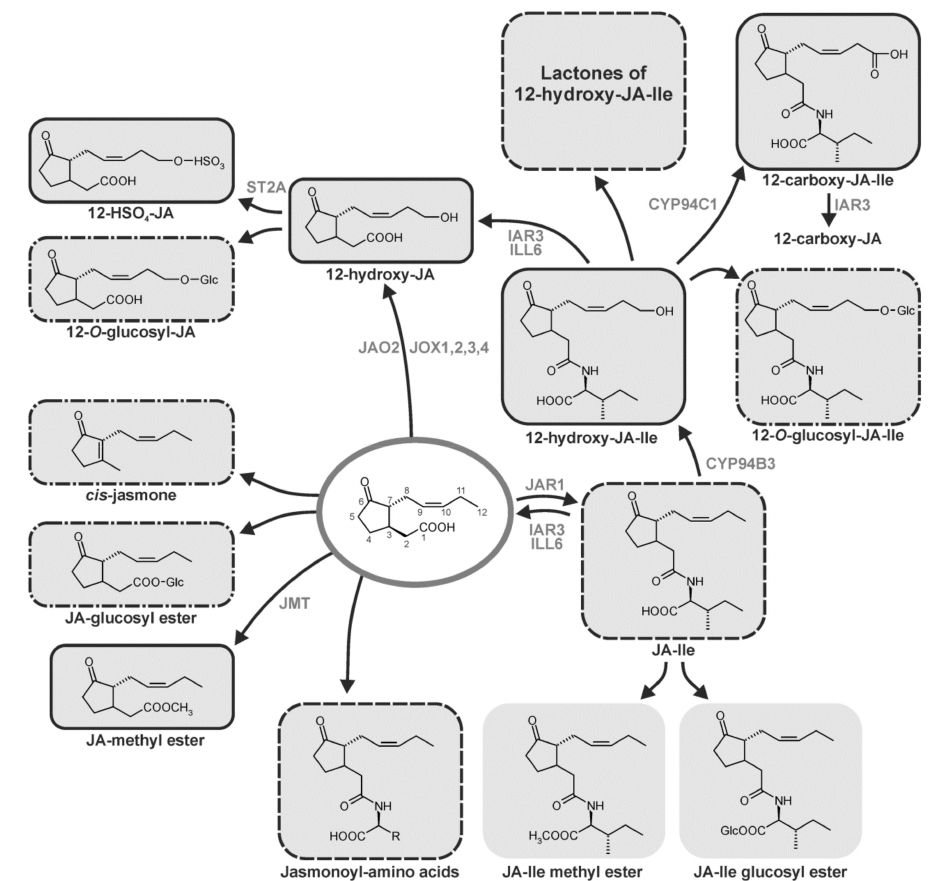
Figure 4. Metabolism of JA. Methylation to JA-methyl ester, JA glucosyl ester